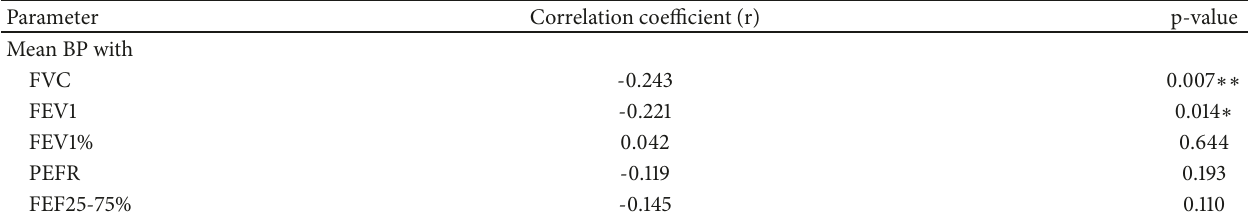
Table 5: Bivariate correlation result between pulmonary function parameters and mean blood pressure in cases and controls at Zewditu Memorial Hospital, Addis Ababa, Ethiopia, 2017.